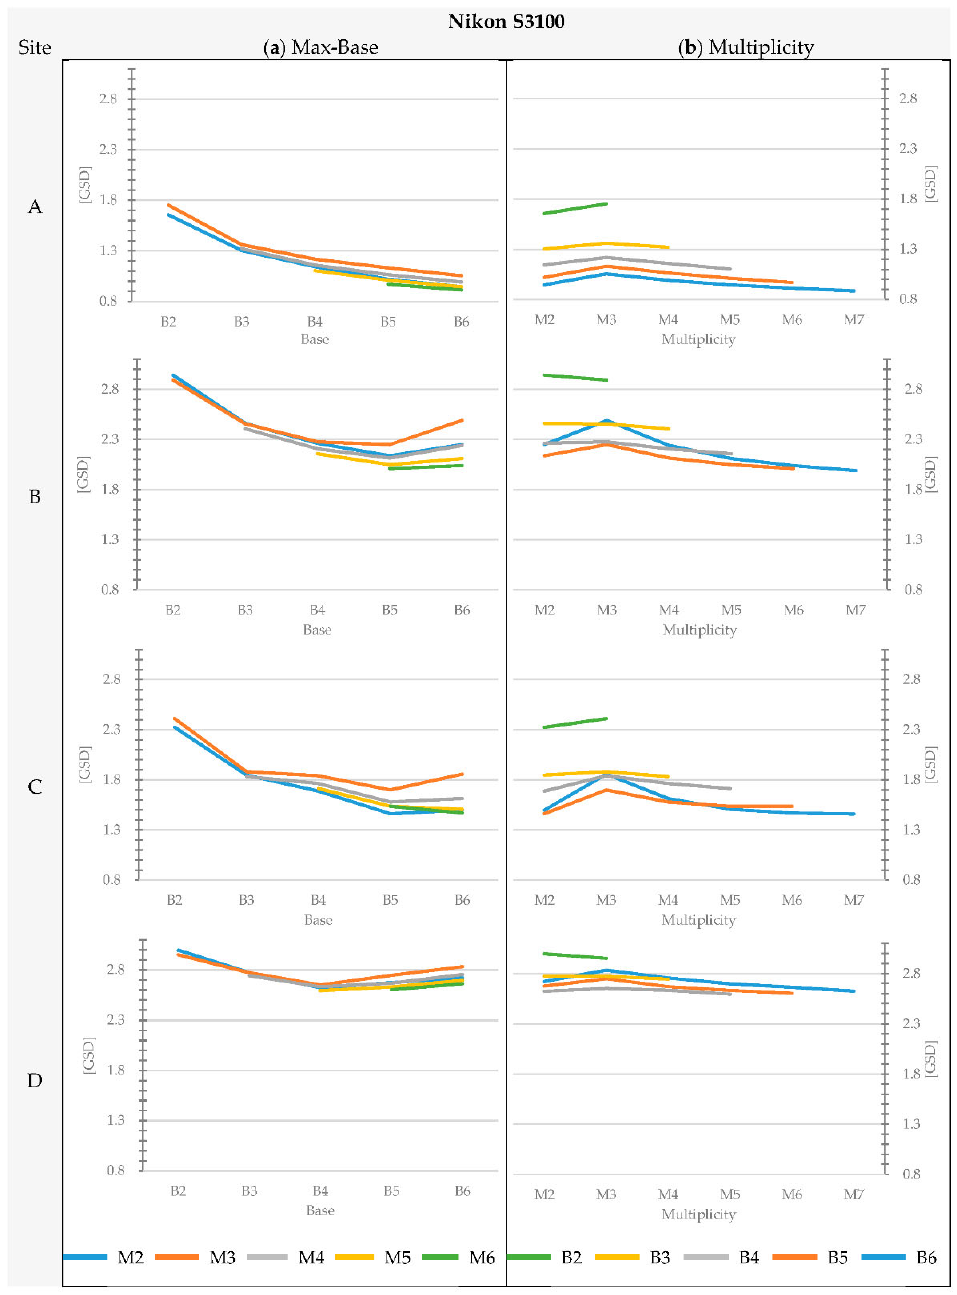
Figure 8. Graphs showing the standard deviation of the elevation disparity between DEMs and the reference model for Sites A, B, C and D, using Nikon S3100, as a function of ( a ) max-base variability and ( b ) multiplicity. (Value of standard deviation for combinations B1-M2: Site A = 2.68, B = 4.18, Site C = 3.67 and Site D = 3.90 times the GSD) .